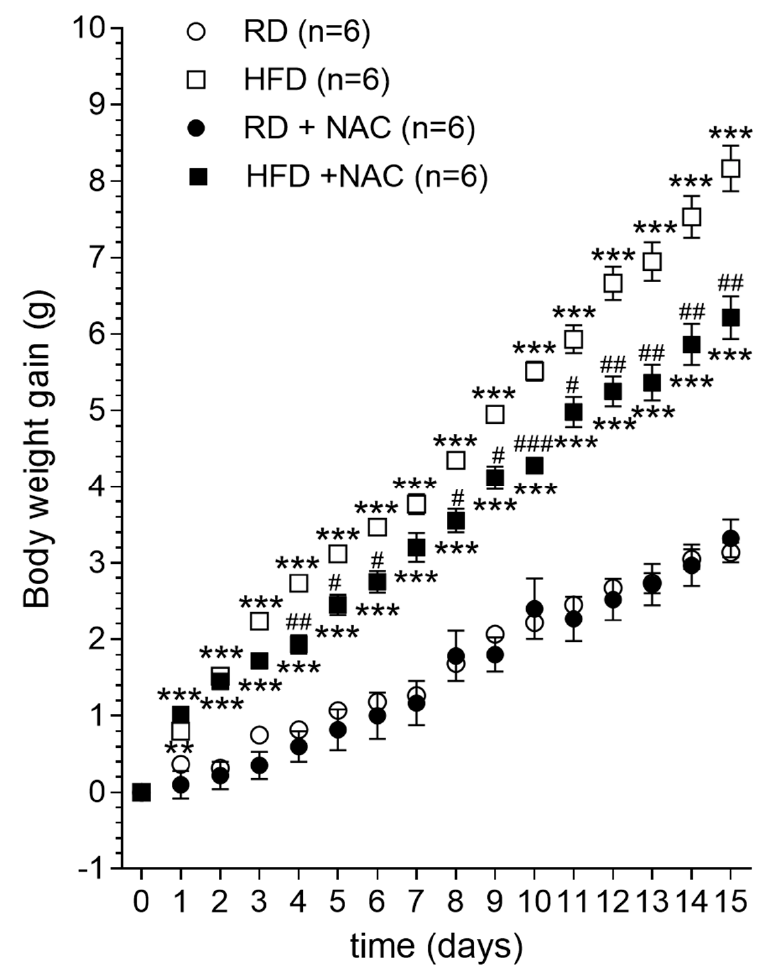
Figure 3. Time-course of body weight gain in young mice fed either RD or HFD for 2 weeks, and the effect of 2g/L N-acetylcysteine co-administered in drinking water. RD: regular diet; HFD: high-fat diet; NAC: N-acetylcysteine. Two-way repeated measures ANOVA revealed an intergroup effect of treatments (n = 6 mice per group, F 3, 20 = 89.39). Mice fed HFD (empty squares) had statistically higher body weight gain than those mice fed RD (empty circles) (** p < 0.01, *** p < 0.001, Bonferroni multiple comparisons post-hoc test). N-acetylcysteine co-administered in drinking water resulted in a significant decrease in body weight gain of animals being feeding with HFD (filled squares) as compared to HFD-primed mice without N-acetylcysteine co-treatment ( # p < 0.05, ## p < 0.01, ### p < 0.001, two-way repeated measures ANOVA followed by Bonferroni multiple comparisons